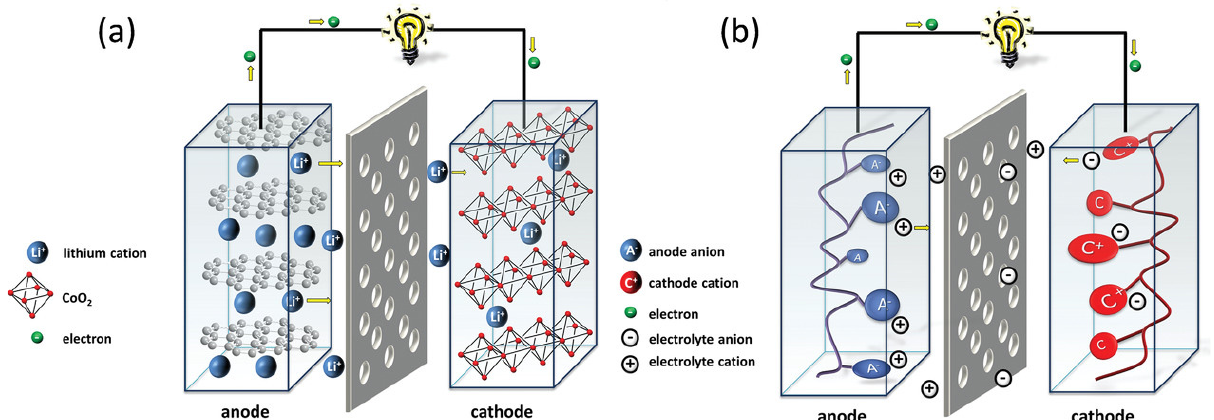
Figure 1. Schematic showing of the processes occurring during discharging of ( a ) traditional inor- ganic and ( b ) organic electrode-based Li-ion batteries. Instead of intercalation-based reactions in inorganic compounds, organic compounds undergo surface-based redox reactions. Reprinted with permission from Ref. [38], Copyright 2016, American Chemical Society.